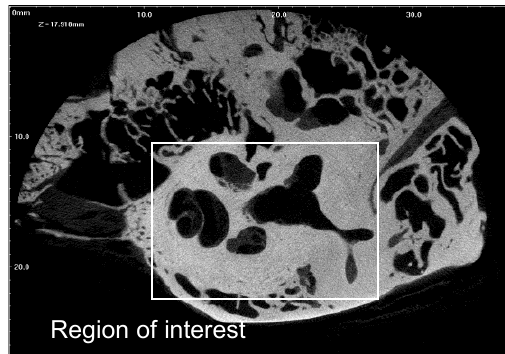
Fig. 2. Example of cross sectional image.